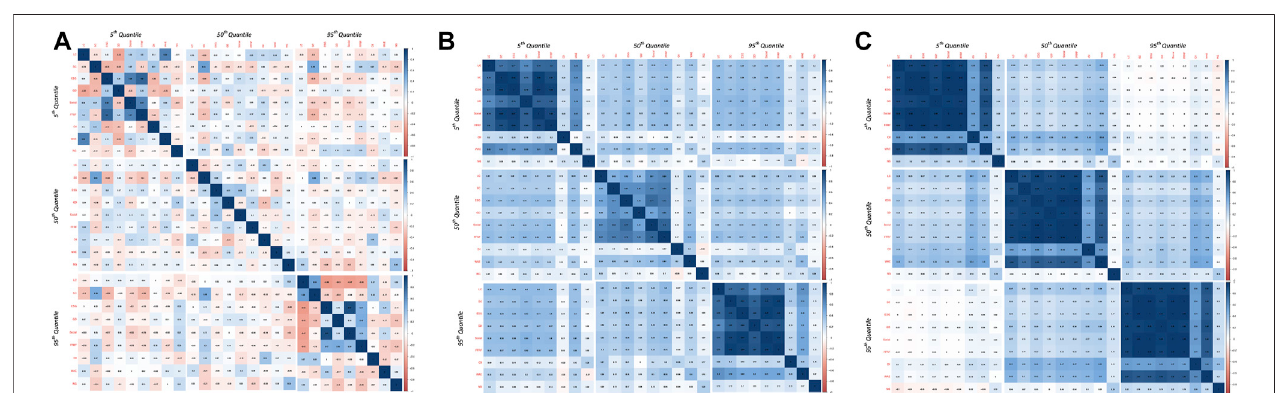
FIGURE 3 | (A) Quantile cross-spectral correlations (short run). (B) Quantile cross-spectral correlations (medium run). (C) Quantile cross-spectral correlations (long